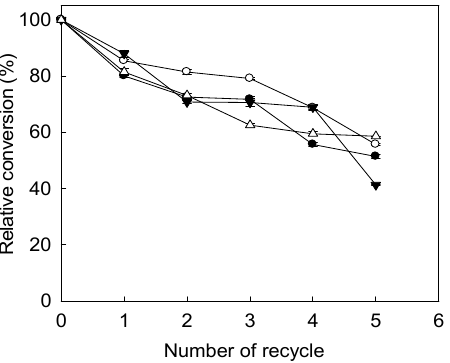
Figure 6. Reusability of Pseudomonas cepacia lipase immobilized on magnetic nanoparticles. Immobilized lipase was recycled without washing ( ▼ ) or after washing with tert -butanol ( ○ ); n -hexane ( ∆ ); and deionized water ( ● ). The initial conversion was defined as 100%. 40% ( w / w of oil) immobilized lipase was used to catalyze transesterification using 4.8 g waste cooking oil under optimal reaction conditions for 72